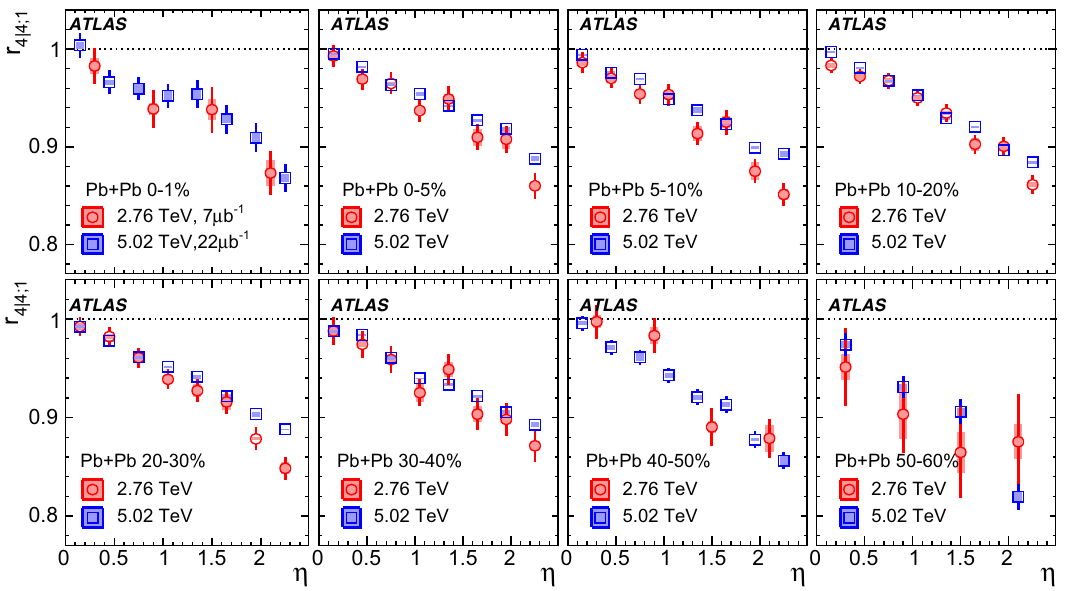
Fig. 8 The r 4 | 4 ; 1 (η) compared between the two collision energies. Each panel shows results from one centrality interval. The error bars and shaded boxes are statistical and systematic uncertainties, respectively